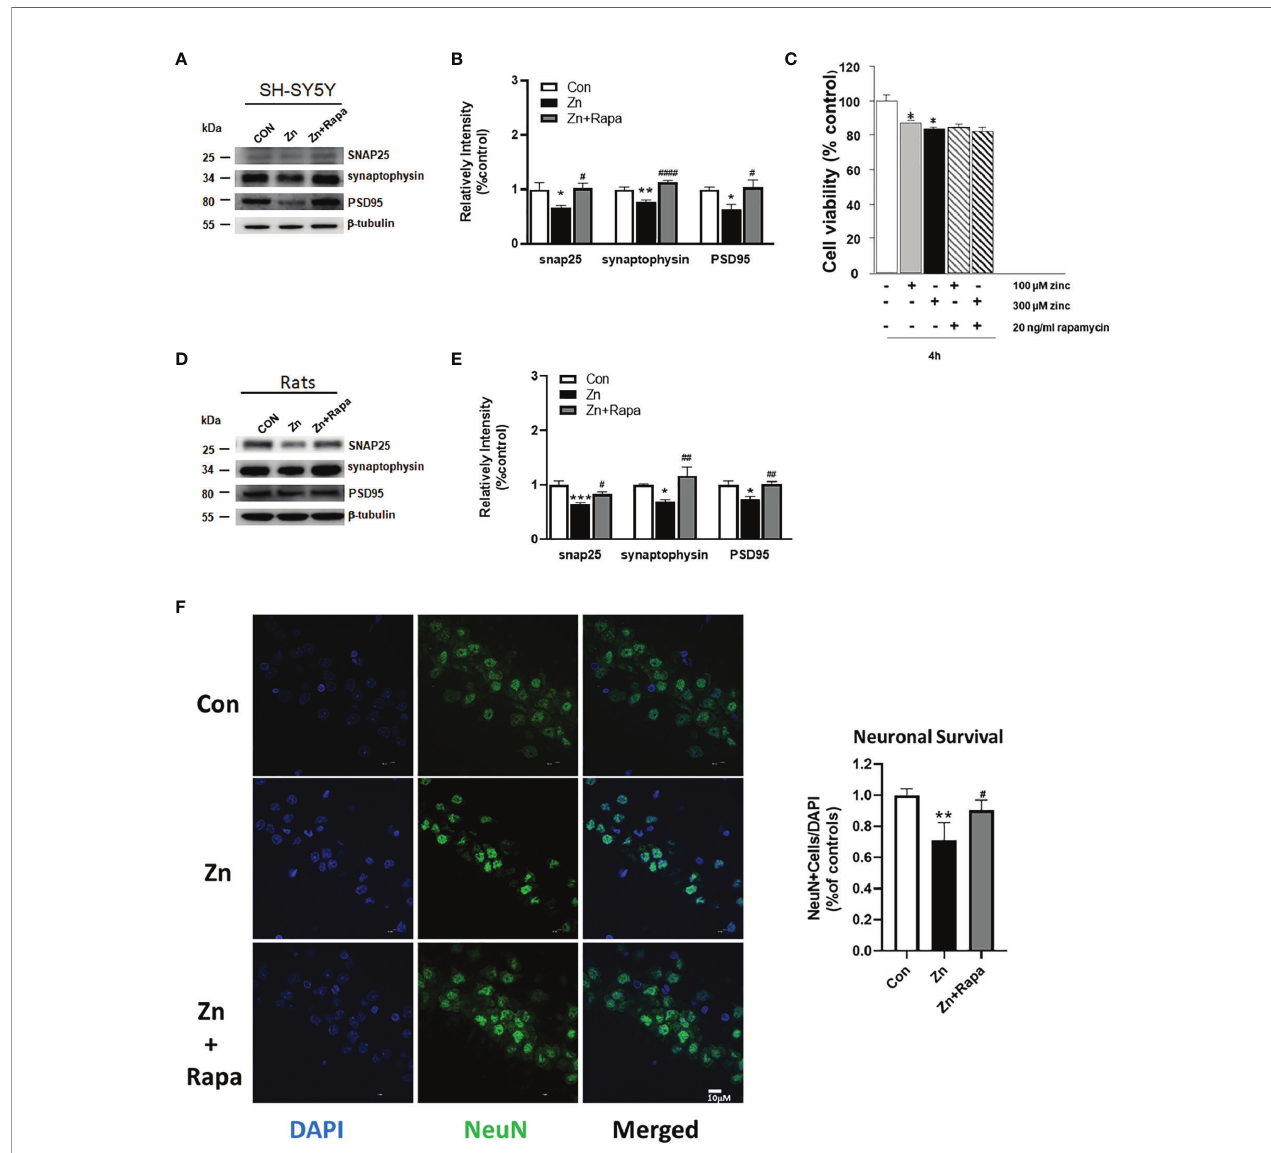
FIGURE 7 | Rapamycin improved synaptic impairment caused by zinc in both SH-SY5Y cells and rats and partially rescued cell death in zinc-induced rats. (A, B) Representative blots and quanti fi cation of the protein expression levels of SNAP25, synaptophysin, and PSD-95 in SH-SY5Y cells in the control, zinc, and zinc +rapamycin groups. n = 3 cell experiments per group. (C) Cell viability was assessed using the Cell Counting Kit-8 (CCK ‐ 8) assay. Cells were pretreated with rapamycin for 1 h and then treated with 100 or 300 µM zinc sulfate for an additional 4 h. (D, E) Representative blots and quanti fi cation of the protein expression levels of SNAP25, synaptophysin, and postsynaptic density protein-95 (PSD-95) in rats in the control, zinc, and zinc+rapamycin groups. n = 4 rats per group in the same membrane. (F) Representative NeuN immunostaining (green) image of the CA1 areas of the brains of the rats in the control, zinc, and zinc+rapamycin groups. DAPI staining showed the nuclei. NeuN/DAPI double-positive cells were counted and analyzed as a percentage of total DAPI+ cells. Scale bar = 10 m m; n = 6 rats per group, *p < 0.05, **p < 0.01, ***p < 0.001 vs. control group; #p < 0.05, ##p < 0.01, ####p < 0.0001 vs. zinc+rapamycin treatment. Quanti fi cations of the blots were normalized to b